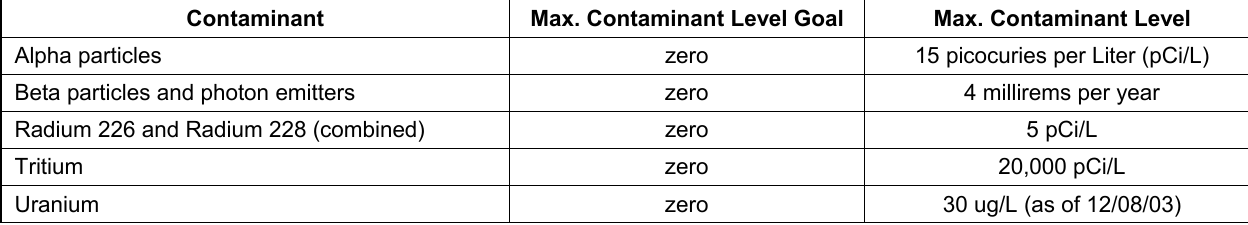
Table 6. EPA national primary drinking water standards for